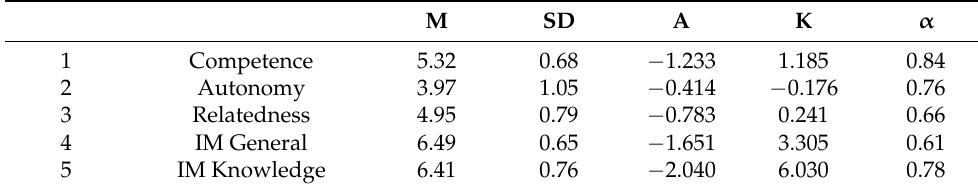
Table 1. Descriptive